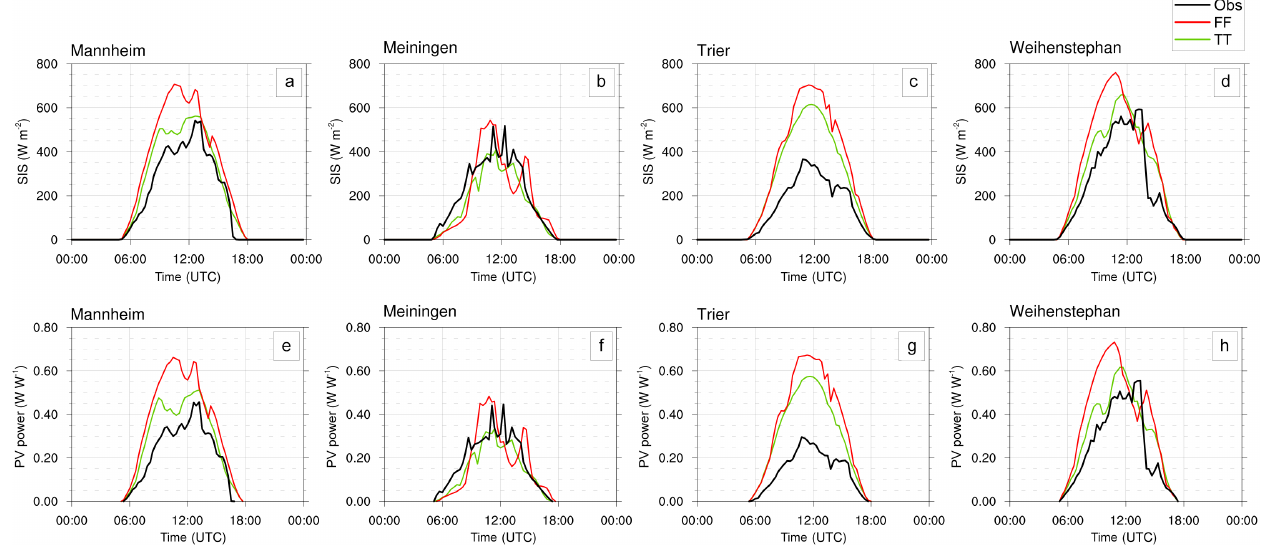
Figure 11. Comparison of observed (black, by pyranometer) and simulated (TT in green, FF in red) surface incoming shortwave irradiance (SIS, a–d ) and the resulting computed normalized PV power (e–h) for the stations Mannheim, Meiningen, Trier and Weihenstephan on 4 April 2014. The normalization is done with respect to peak power. Table 7. Statistical measures describing the quality of the simulated PV-power values using data of all 26 pyranometer stations for different lead times (3 April 2014: 0–23h; 4 April 2014: 24–47h; 5 April 2014: 48–72h; 3–5 April 2014: 0–72h). Values are given for the root mean square error (RMSE), the mean absolute error (MAE), the bias (BIAS), the SD of errors (SD) and the minimum and maximum error ( E min , E max ) in W m − 2 . Bold values mark the better simulation.